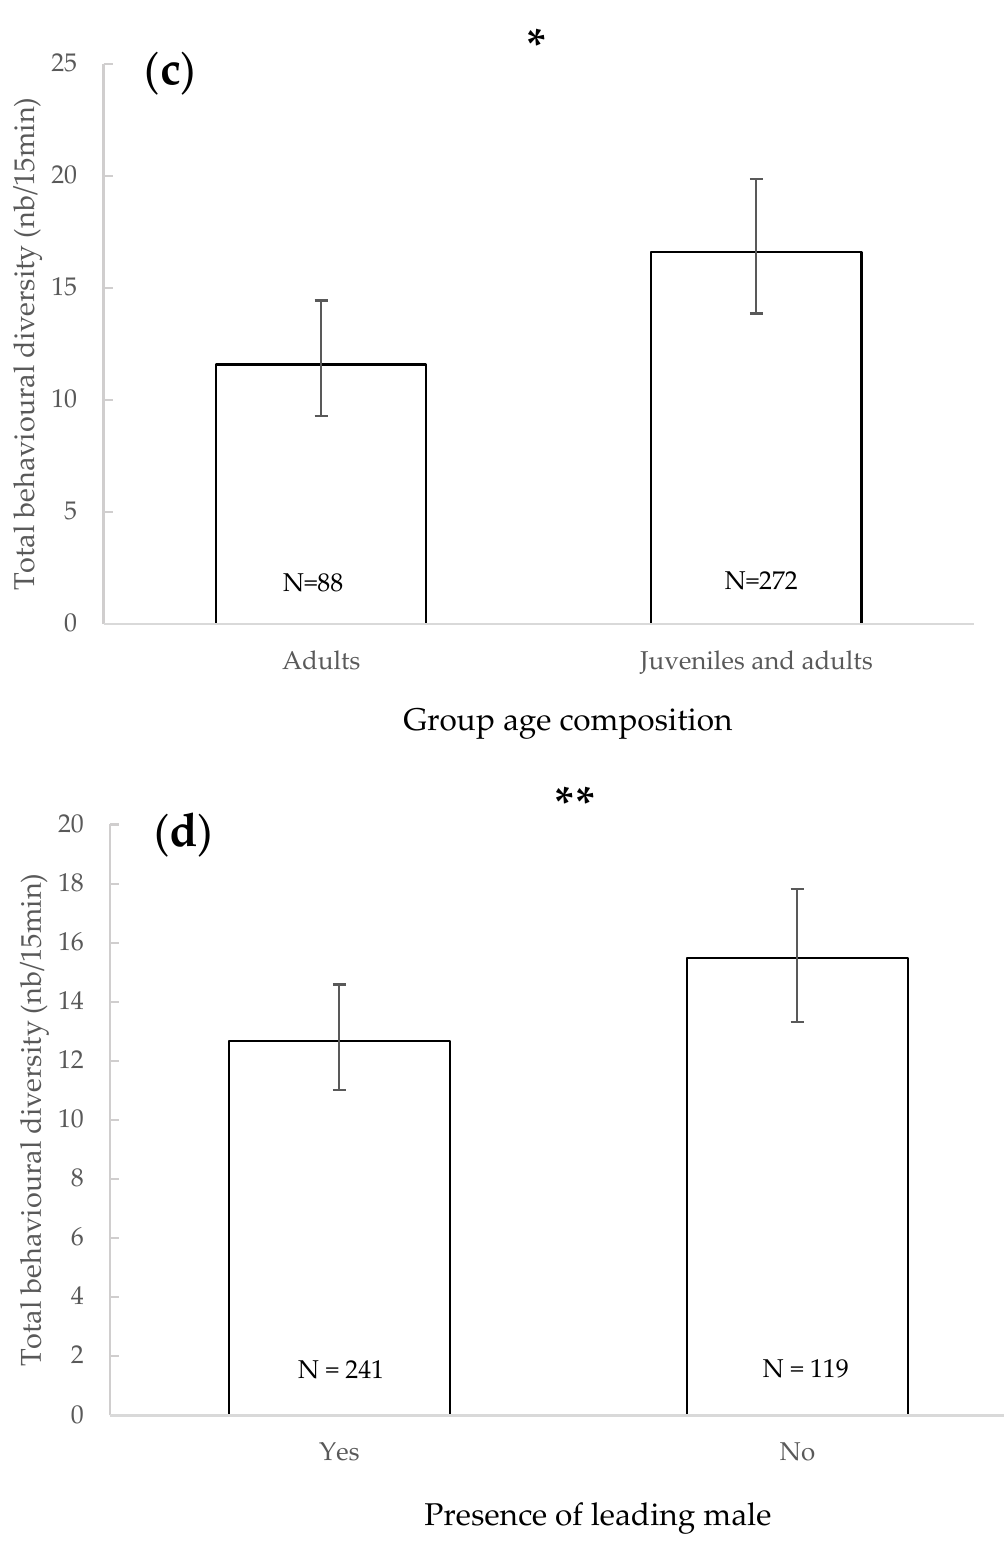
Figure 1. Mean of total behavioural diversity and 95% confidence intervals according to the number of individuals present ( a ), the group sex composition ( b ), the group age composition ( c ) and the presence of the leading male ( d ). *: p < 0.05, **: p < 0.01 (Wald chi-squared test). N: number of observations.